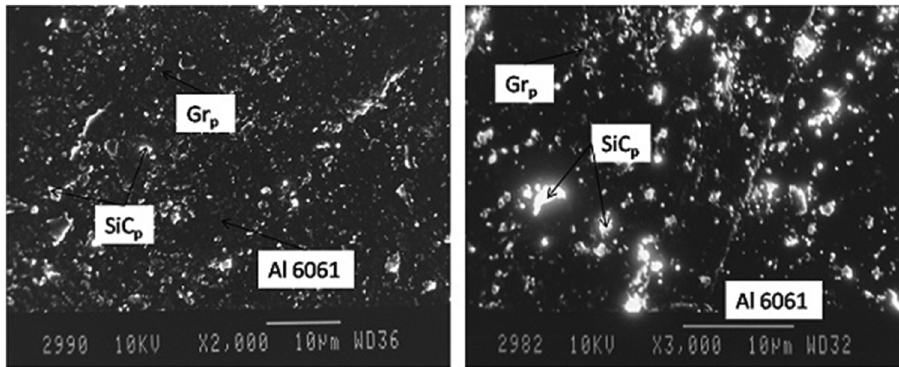
Figure 1: SEM images of Al/10 wt%SiC/3 wt%Gr – MMC hybrid composite before